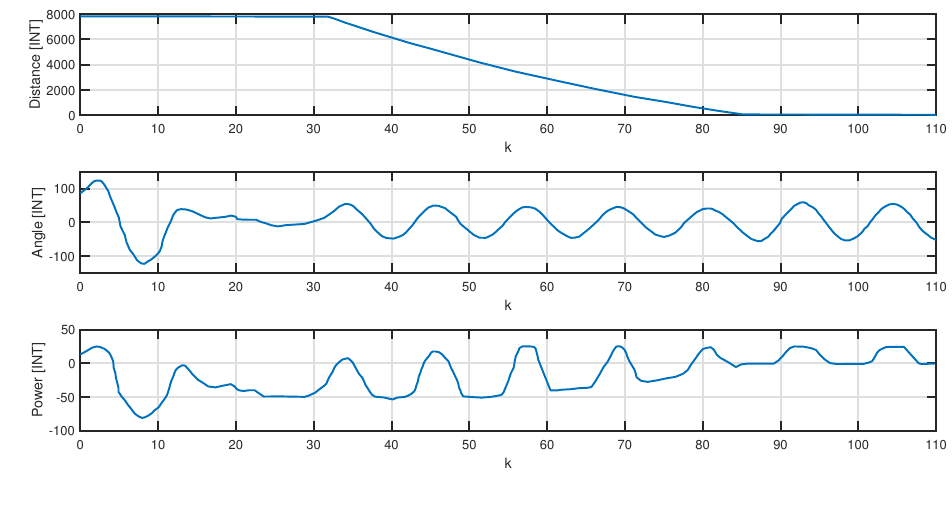
Figure 11. PID control: small gain—1.